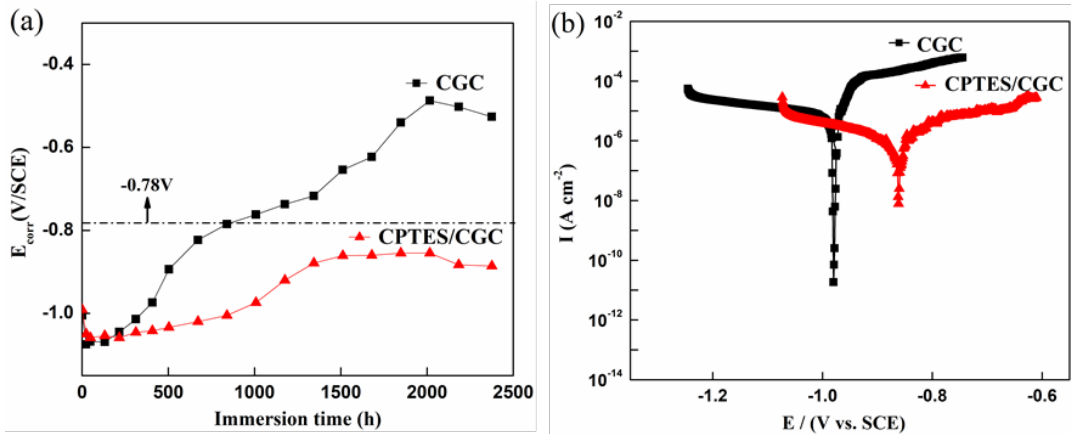
Figure 6. Electrochemical tests in 3.5 wt % NaCl solution for CGC and CPTES/CGC. ( a ): open circuit potential and ( b ): potentiodynamic polarization curves.